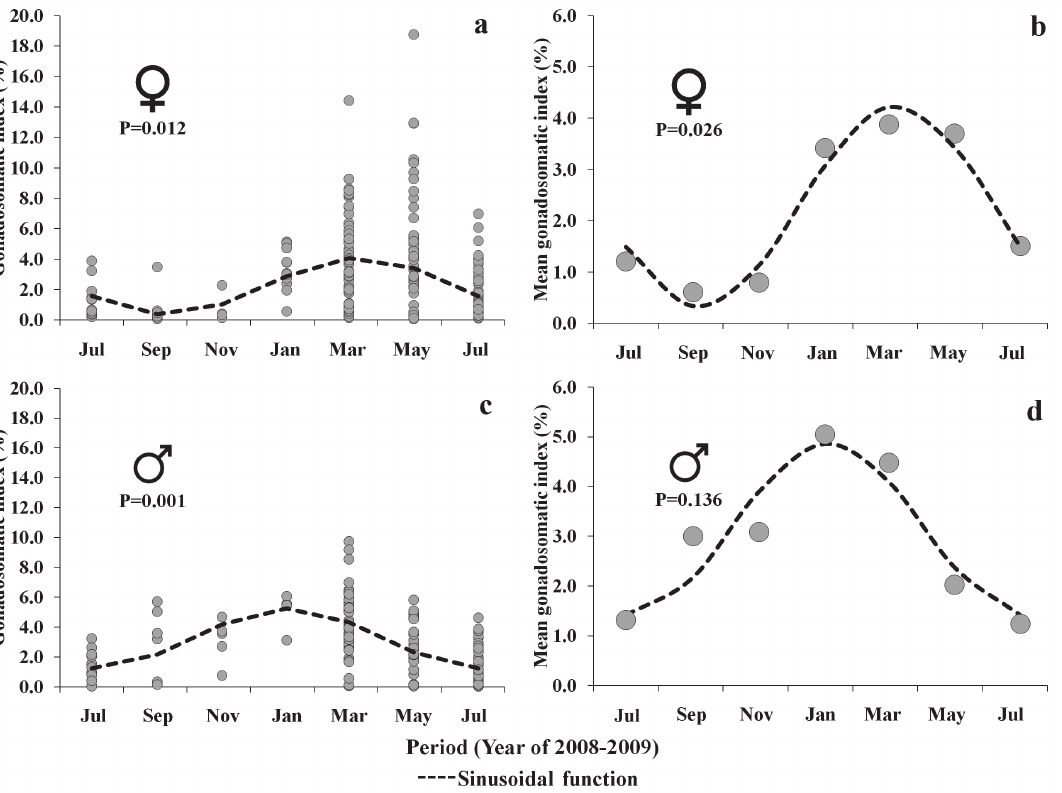
Fig. 4. Bimonthly variation in the raw data ( a , c ) and mean values ( b , d ) of the gonadosomatic index (GSI) for female ( a , b ) and male ( c , d ) of the catfish Auchenipterichthys longimanus collected from July 2008 to July 2009 in the Caxiuanã National